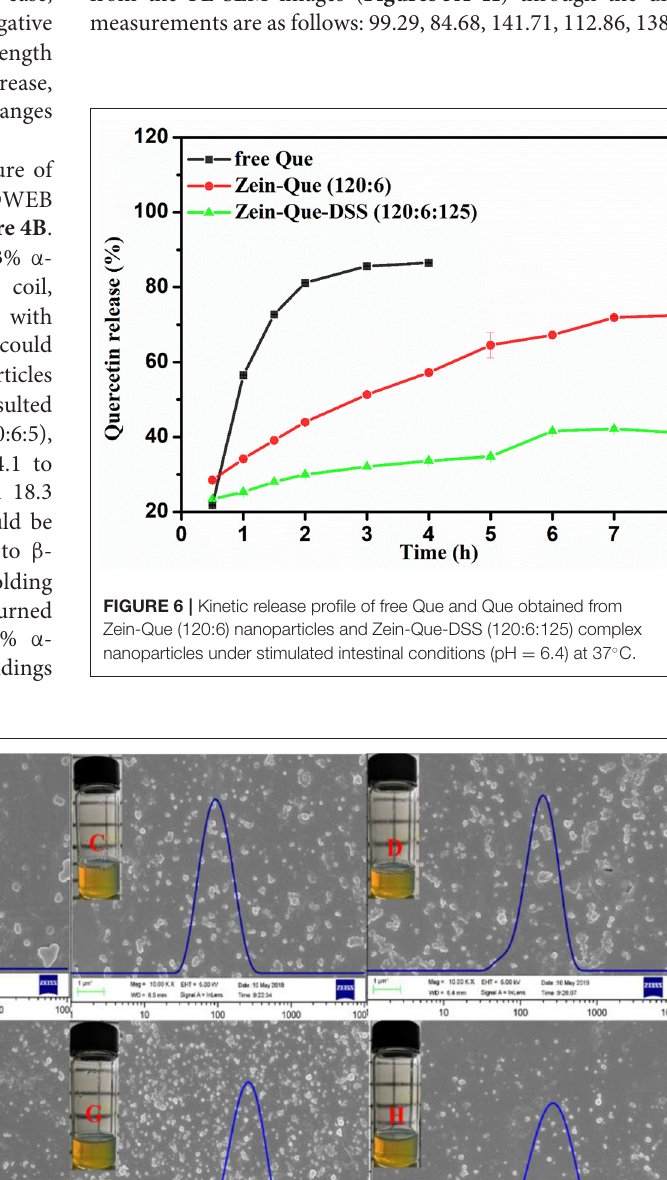
Frontiers in Chemistry |